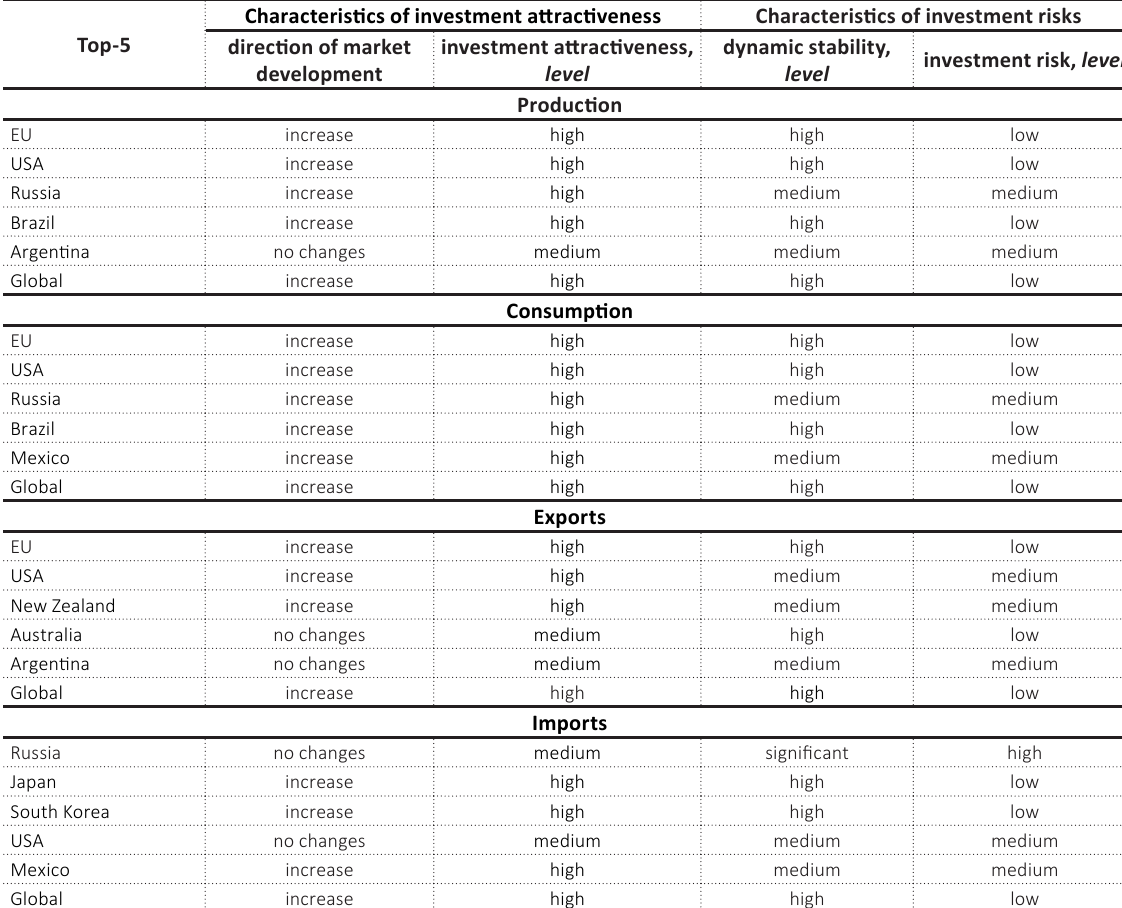
Table 4. Investment attractiveness and risks of investing in the global cheese